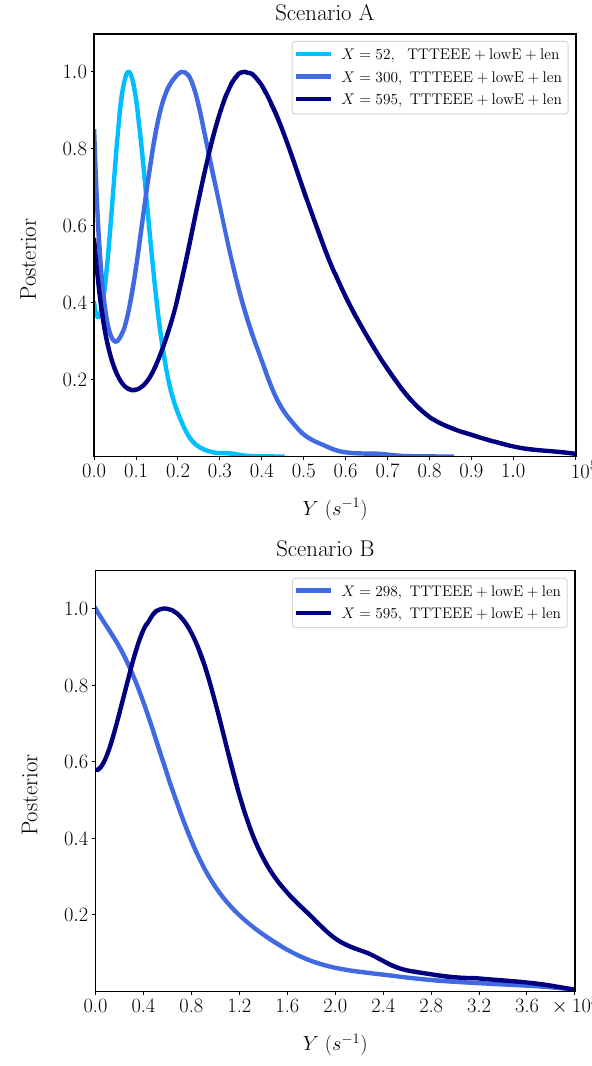
Fig. 2 1D marginalised posteriors for the effective transport rate Y (Eq. (27)) obtained from our MCMC analysis for a range of fixed effec- tive mass values X = X scan in scenarios A (top panel) and B (bottom panel),whoseparameterspacesaredefinedinEqs.(28)and (29)respec- tively. The data used are the TTTEEE+lowE+lensing combination from the Planck 2018 data release [1] Table 2 Marginalised one-sided 95% credible limits on the effective transport rate Y and the equivalent free-streaming redshift z fs (Eq. (32)) for fixed values of the effective mass parameter X (and their equivalent parent neutrino mass m ν H assuming T 0 = T ν, 0 ) in scenarios A and B X Y (s − 1